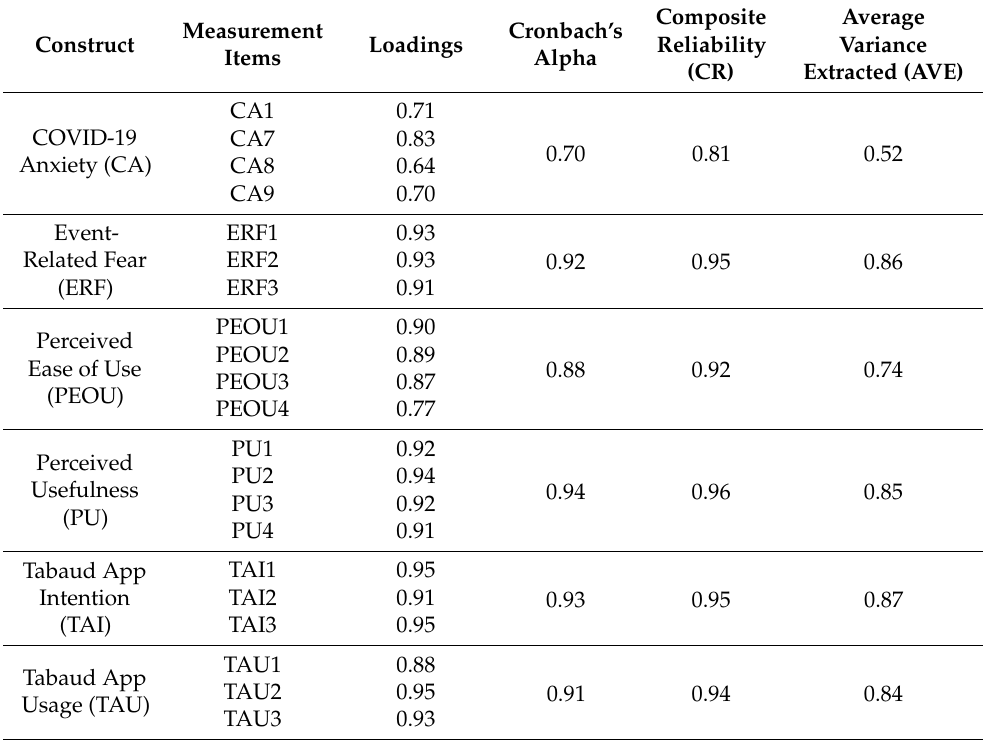
Table 2. Item Loading, Cronbach’s alpha, Composite Reliability, Average Variance Extracted.